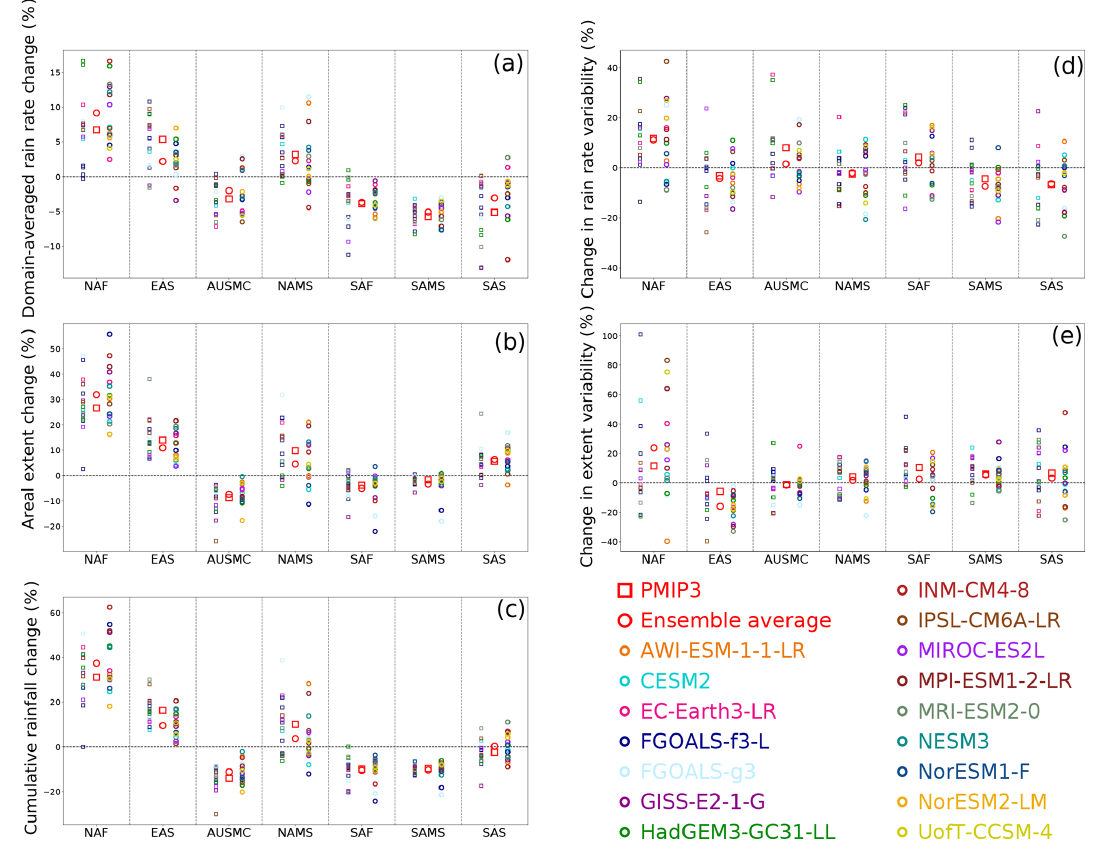
Figure 7. Relative changes in individual midHolocene monsoons. Five different monsoon diagnostics (see Sect. 2.2) are computed for each of seven different regional domains (Christensen et al., 2013). (a) The change in area-averaged precipitation rate during the monsoon season (May–September) for each individual monsoon system. (b) The change in the areal extent of the regional monsoon domains. (c) The percentage change in the total amount of water precipitated in each monsoon season (computed as the precipitation rate multiplied by the areal extent). (d) Change in the standard deviation of interannual variability in the area-averaged precipitation rate. (e) The change in standard deviation of the year-to-year variations in the areal extent of the regional monsoon domain. The abbreviations used to identify each regional domain are North American Monsoon System (NAMS), northern Africa (NAF), southern Asia (SAS), and East Asia summer (EAS) in the Northern Hemisphere and South American Monsoon System (SAMS), southern Africa (SAF), and Australian–Maritime Continent (AUSMC) in the Southern